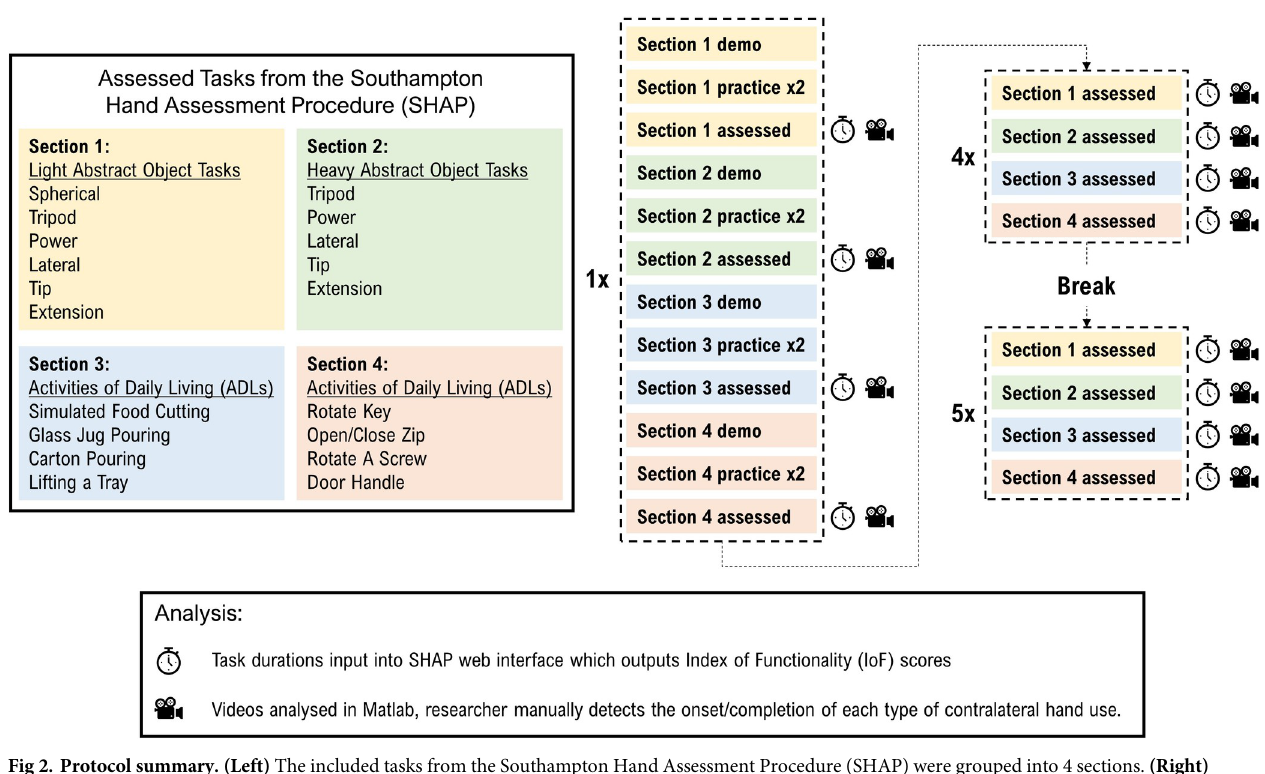
Fig 2. Protocol summary. (Left) The included tasks from the Southampton Hand Assessment Procedure (SHAP) were grouped into 4 sections. (Right) During the 1 st attempt, the researcher demonstrated the tasks in each section, the participant was then given 2 opportunities to practice before the timed and video recorded attempt. For all further attempts, no opportunities to practice were given prior to the assessed attempts. (Bottom) Analysis of the SHAP completion time was undertaken using the online SHAP analysis software. Analysis of the time spent using the contralateral hand was undertaken through manual review of the video data.